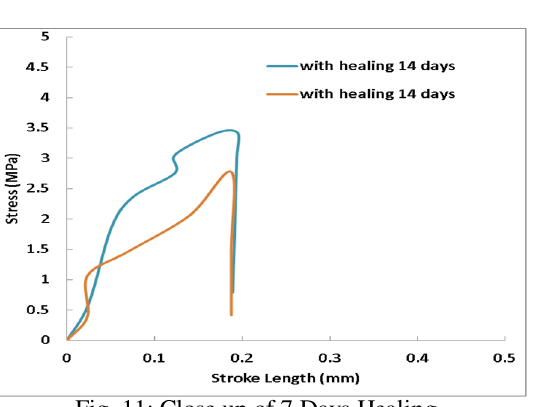
Fig. 10: Compression Testing Curves